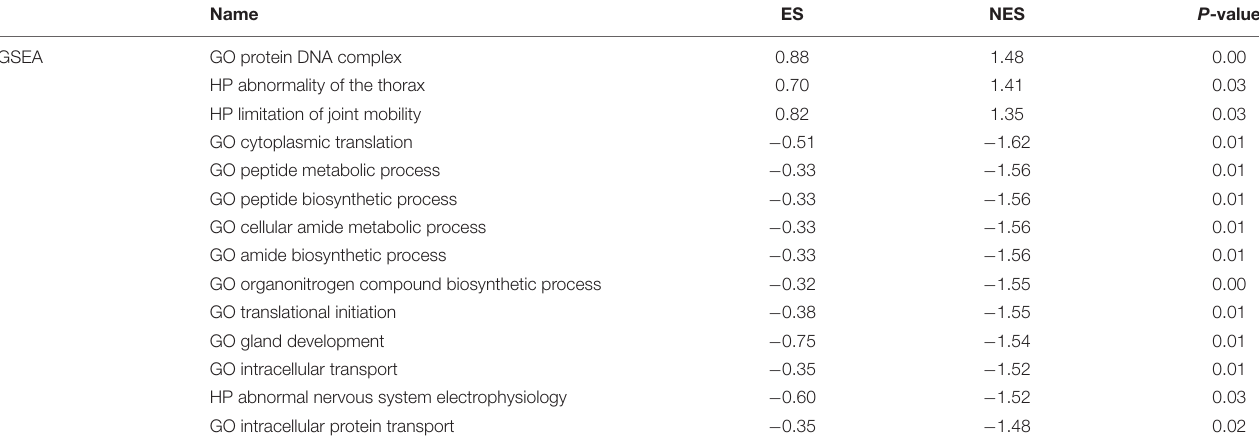
TABLE 2B | Functional enrichment analysis of DE-RBPs in PAAD by gene set enrichment analysis (GSEA).